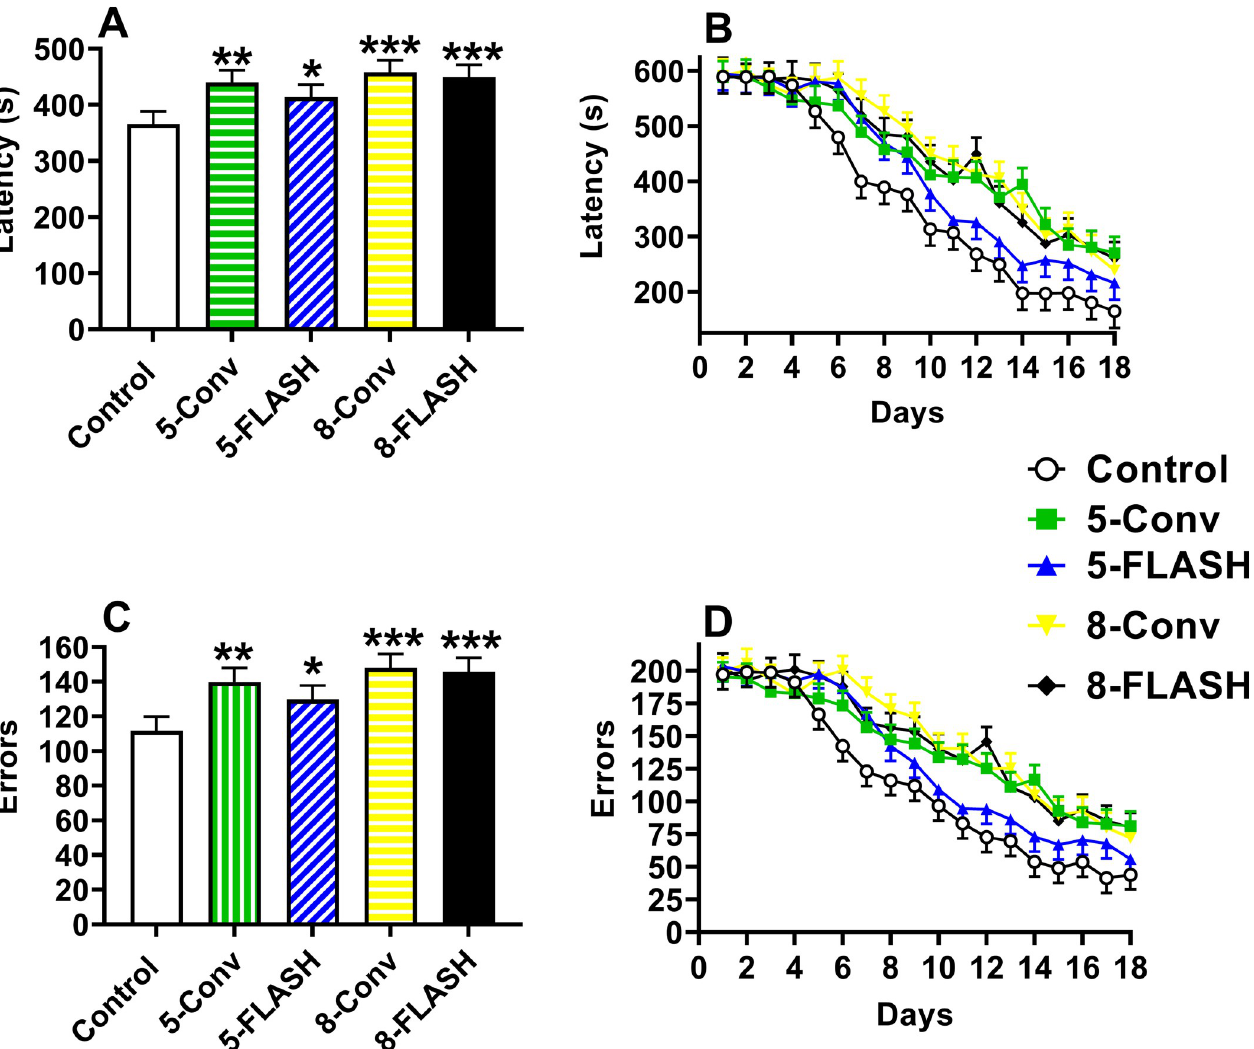
Fig 5. The Cincinnati water maze latency [s (mean ± SEM)] and number of errors (mean ± SEM) of proton irradiated and control rats. A . The overall effect on latency where irradiated groups took longer to locate the platform compared with controls. B. The learning curves for latency. There was an interaction of exposure x day that is described in the results. Differences between the controls and irradiated groups began after day 5 and from day 10 to 18 all groups except the 5-FLASH group took longer to locate the platform. C. The overall effect on errors where irradiated groups had more errors to locate the platform. D. The learning curves for errors. Similar to latency there was an exposure x day interaction that is described in the results. N = 19/sex/exposure except control male and 5-FLASH male = 18. � p < 0.05, �� p < 0.01, and ��� p < 0.001 compared with